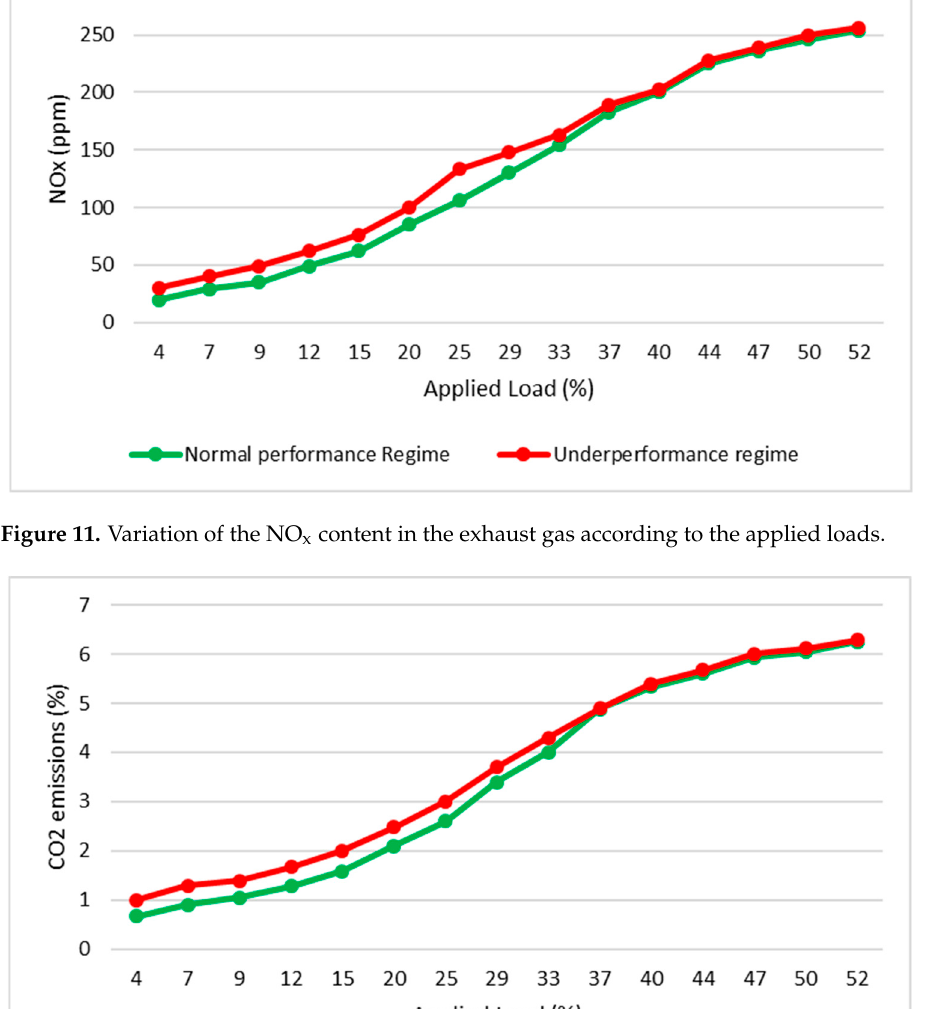
Figure 11. Variation of the NO x content in the exhaust gas according to the applied loads.